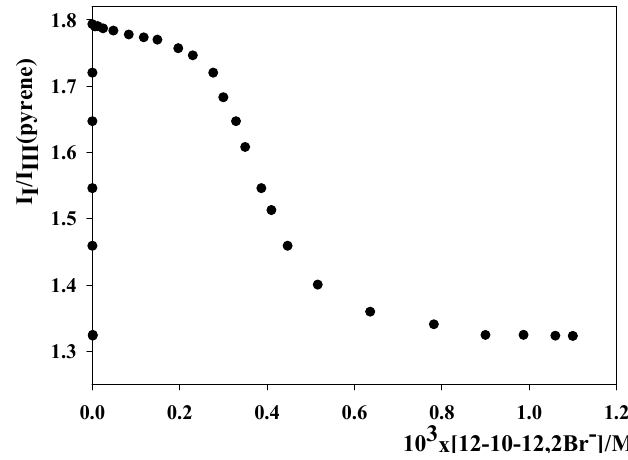
Figure 1. Dependence of the pyrene I 12-10-12,2Br − aqueous solutions in the presence of NaOH 5 × 10 − 3 M. T = 303